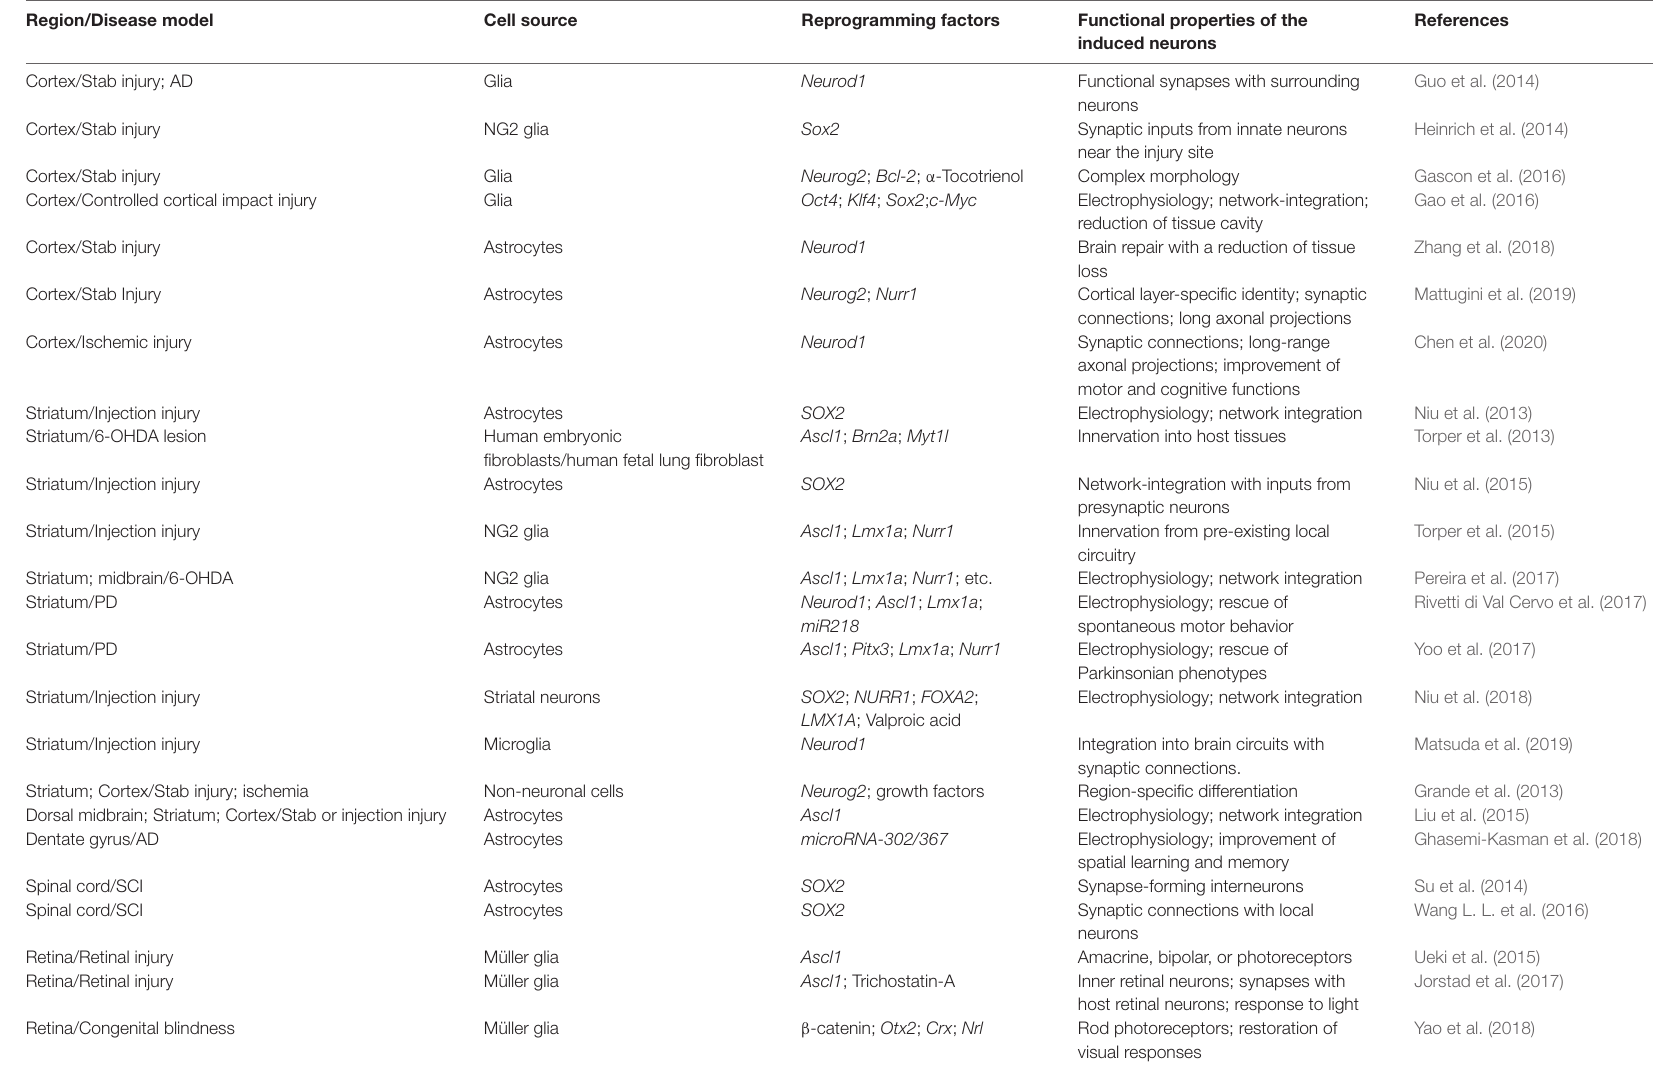
TABLE 1 | Induced neurogenesis in the adult central nervous